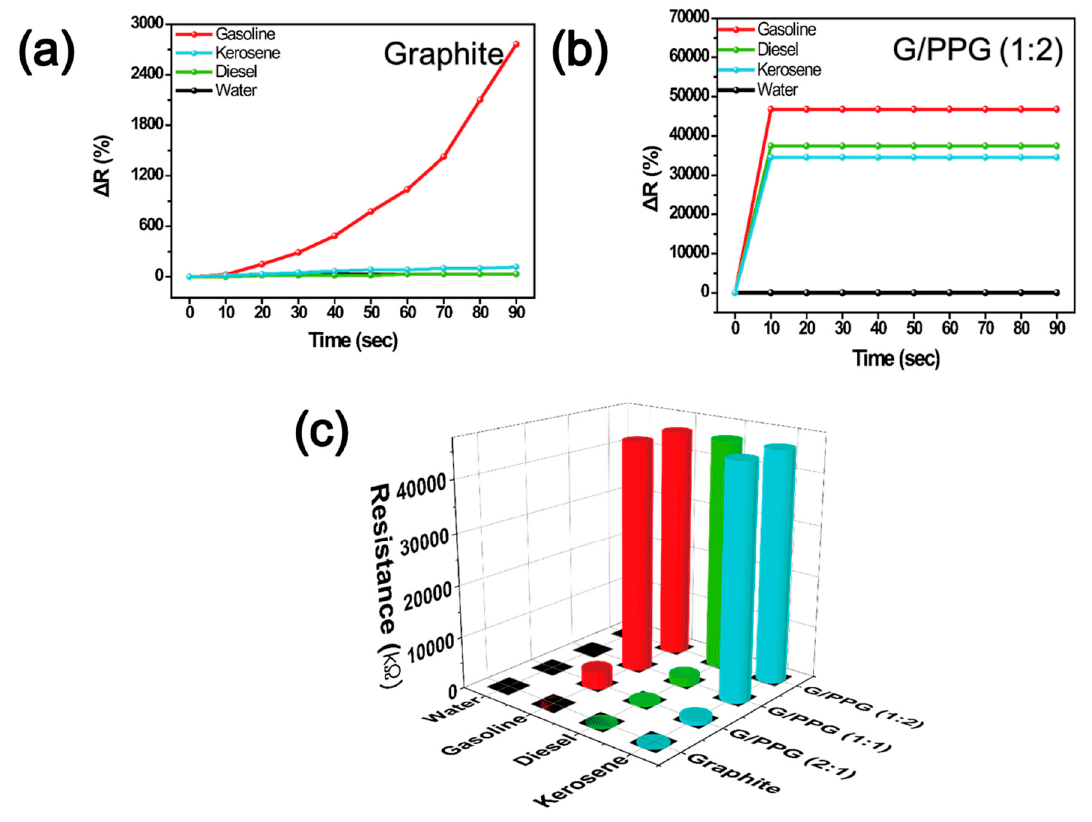
Figure 3. Sensitivity of ( a ) pure graphite and ( b ) G/PPG (1:2) HC film, and ( c ) Sensitivity comparison of G/PPG HC films for different liquid organic compounds and water.